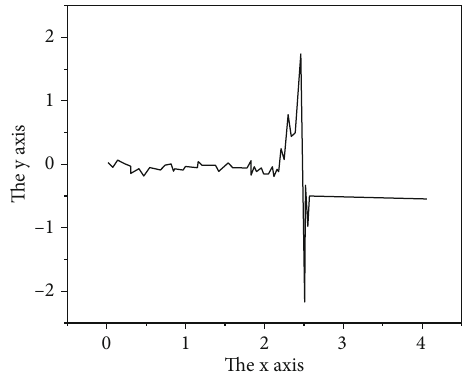
Figure 4: Acceleration curve.